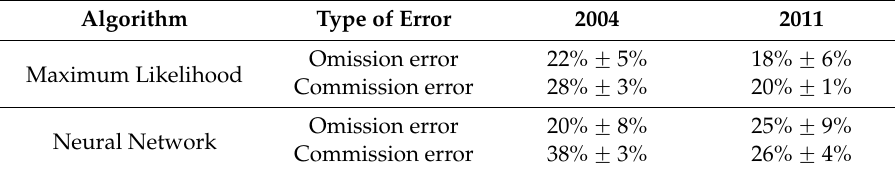
Table 2. Omission and commission errors for the “mangrove” class for the images from 2004 and 2011. The results for the Maximum Likelihood and the neural network algorithms are shown individually. The results were obtained with the five iterations of the cross-validation technique.